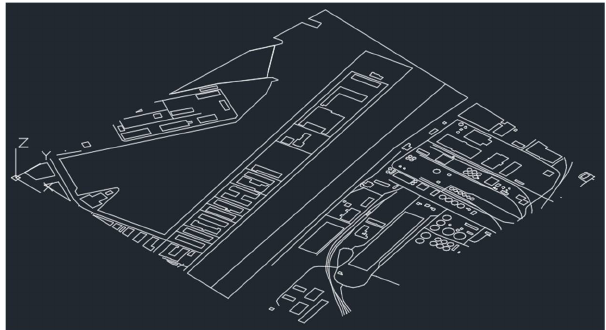
Figure 9. Sketch of the area created in the AutoCAD software.